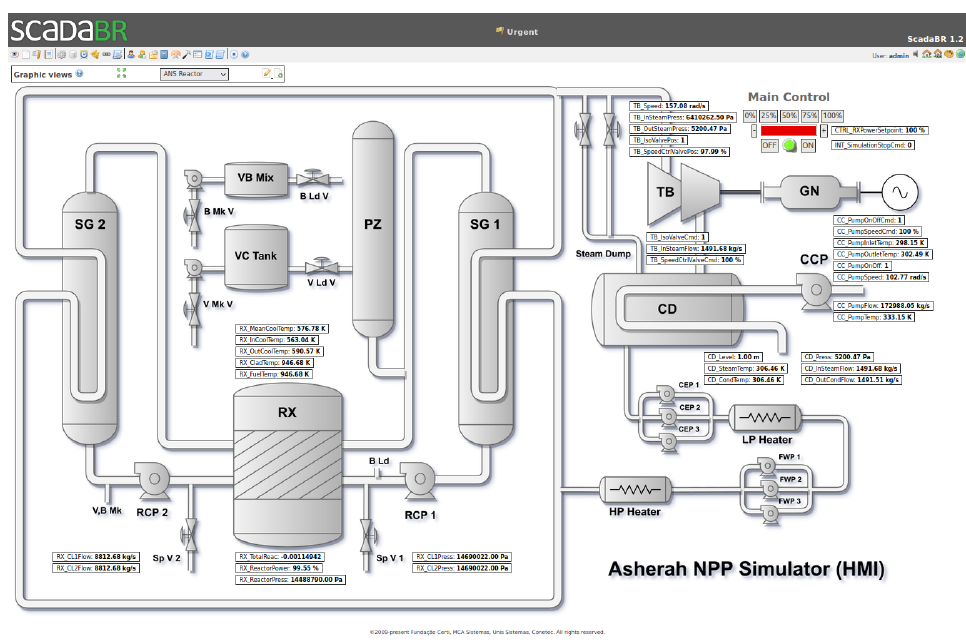
Figure 9. ScadaBR HMI—Synoptic Panel 1 (Numerical and Main Control).